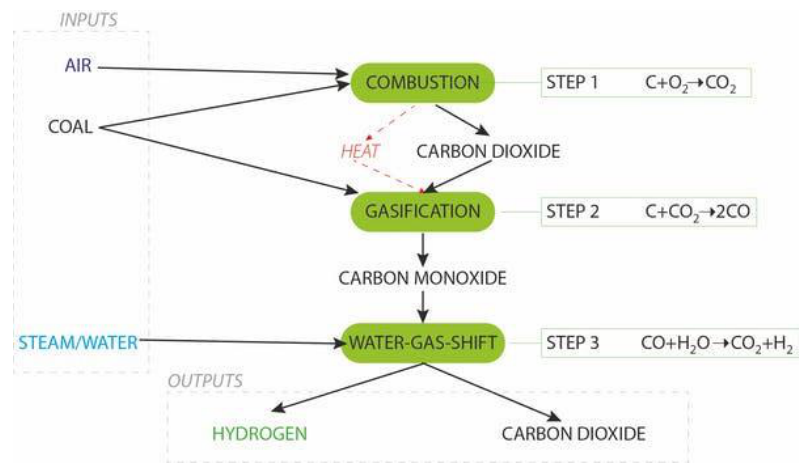
Figure 1. Coal-based hydrogen production